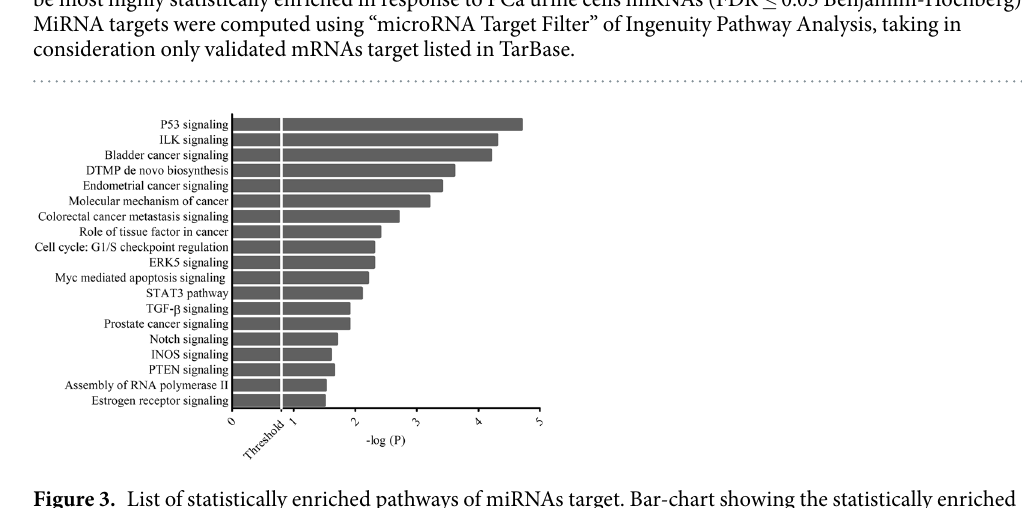
Figure 2. List of diseases and functions of miRNAs target. Bar-chart showing the 19 Gene ontologies found to be most highly statistically enriched in response to PCa urine cells miRNAs (FDR ≤ 0.05 Benjamini-Hochberg).